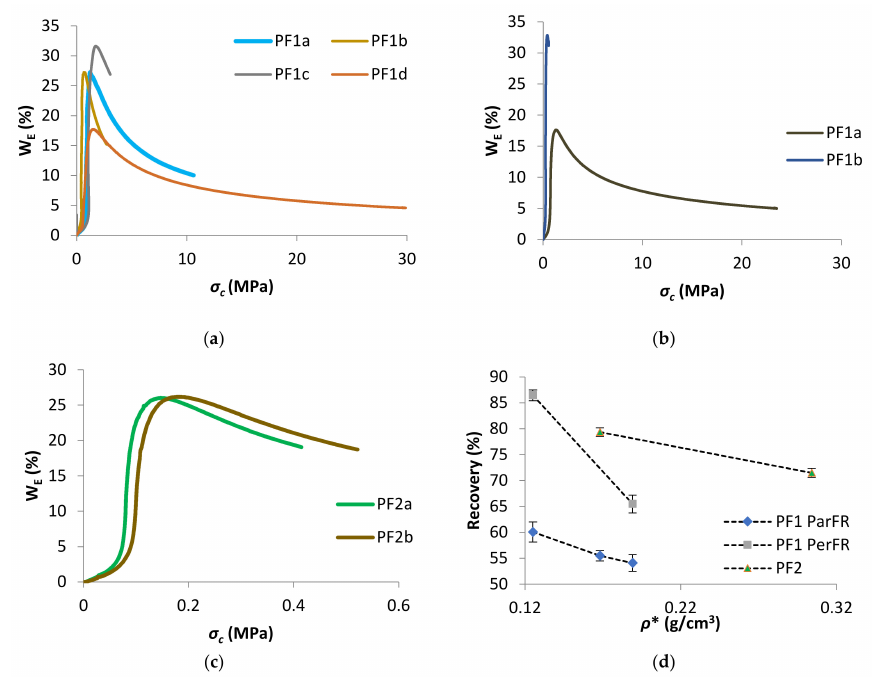
Figure 12. W E as a function of σ c for ( a ) PF1 ParFR, ( b ) PF1 PerFR, and ( c ) PF2, and ( d ) recovery as a function of ρ * for PF1 ParFR, PF1 PerFR and